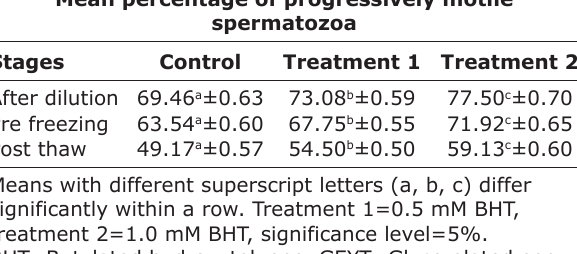
Table-3: HOS reactive spermatozoa in the semen of Hariana bulls extended in GEYT with BHT supplementation during different stages (after dilution and prefreezing) of cryopreservation and following thawing (mean±SEM, n=24).